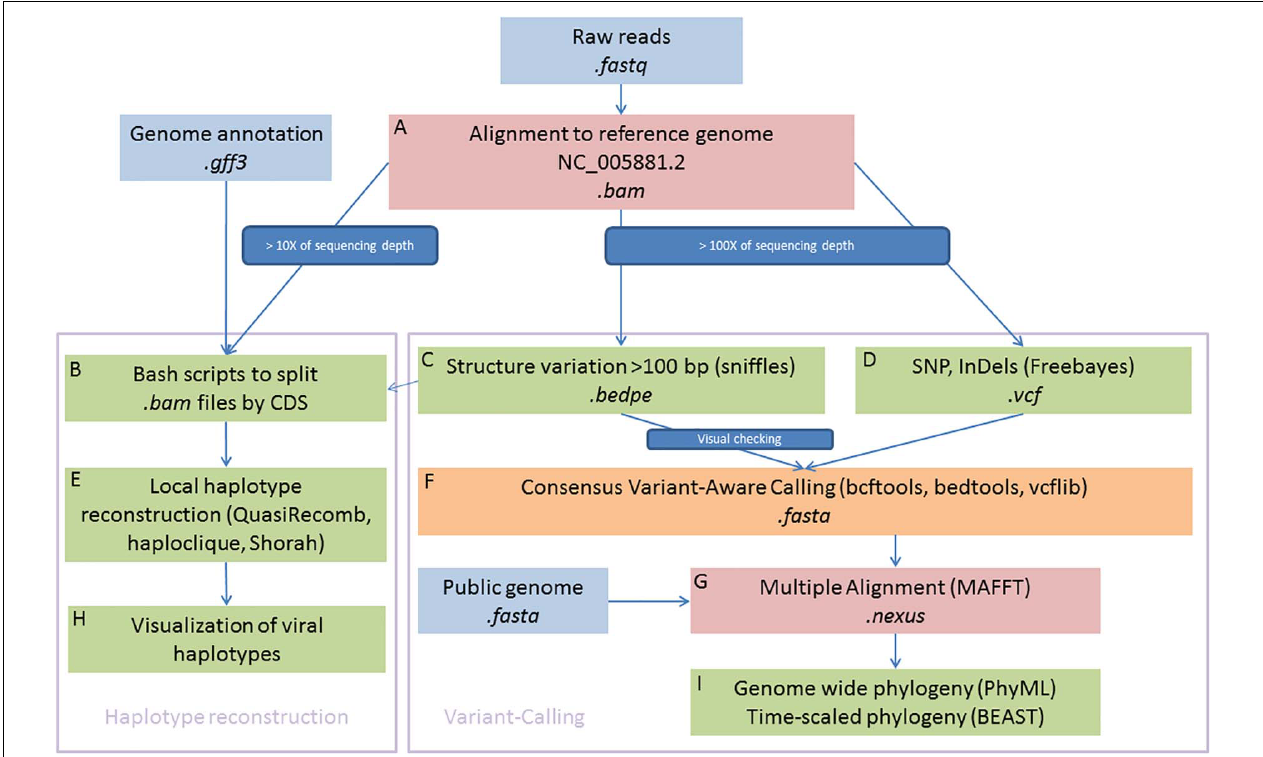
FIGURE 1 | Schematic illustration of bioinformatics framework. In summary, the right part is devoted to genome-wide phylogenetic approaches and the left part aims to reconstruct local viral haplotypes. Sequences were aligned to reference genome (A) and consensus were used to detected haplotypes (B,E,H) and SNPs (C,D,F) . Multiple alignement were used to built phylogenies (G,I)